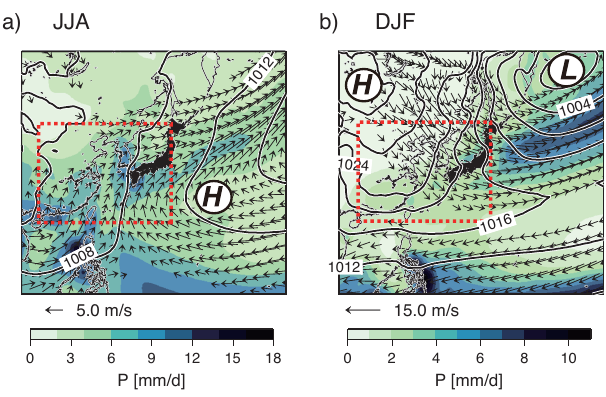
Figure 1. Climatological fields of precipitation (shading), sea level pressure (solid contours, contour interval 4hPa) and surface wind (vectors: ms − 1 ) for East Asia during (a) summer (JJA) and (b) win- ter (DJF). The symbols H and L are centers of high and low surface air pressure, respectively. The dotted box represents the East Asian monsoon region defined by Ding and Chan